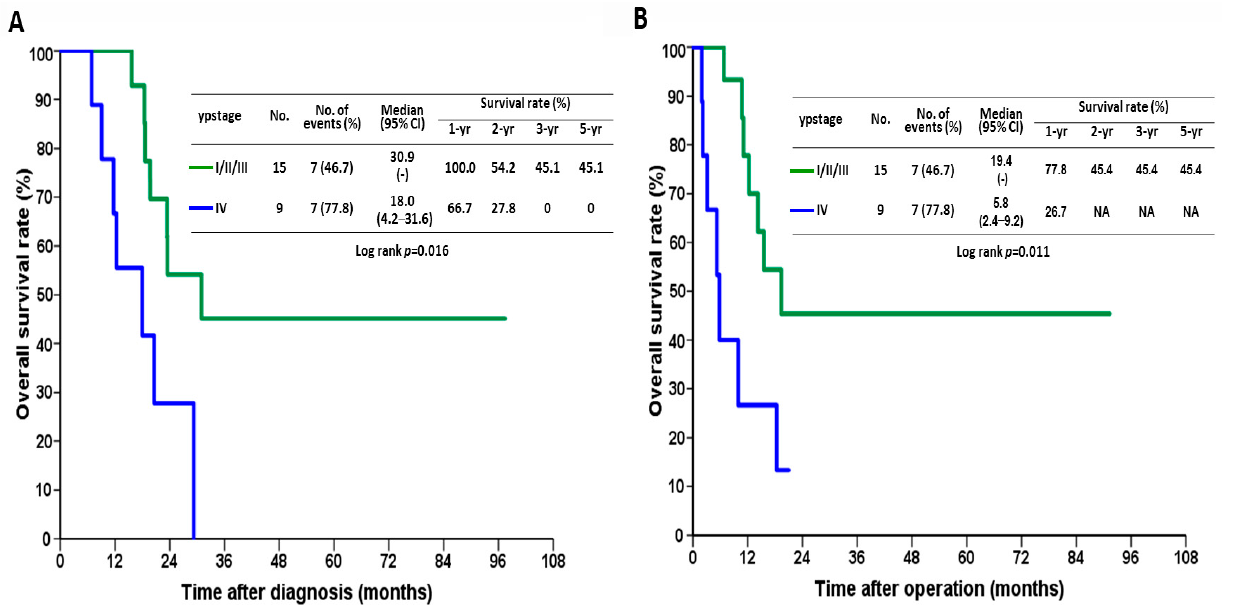
Figure 3. Kaplan–Meier survival curves after the ( A ) initial diagnosis and ( B ) operation in terms of yield pathological stage (ypstage).